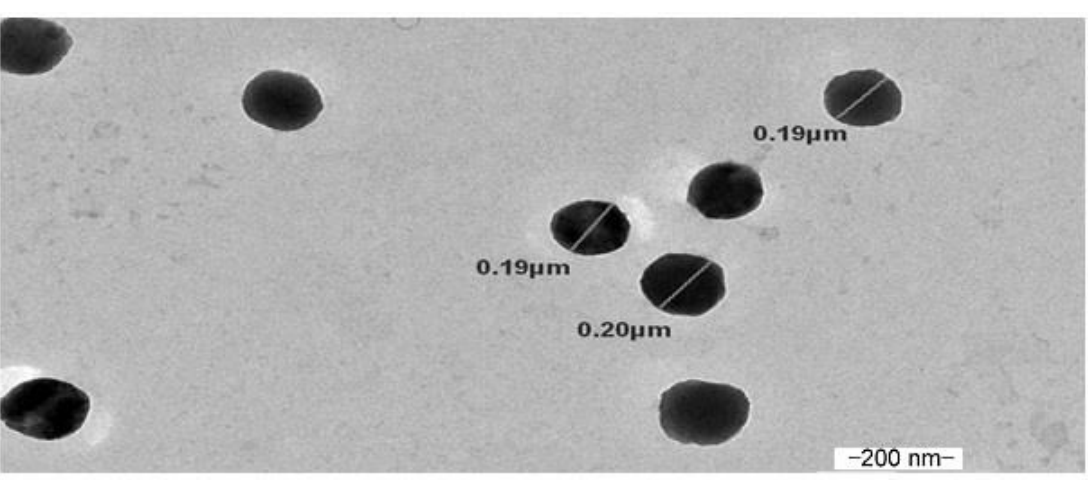
Figure 4. In vitro release profile of CS NPs loaded with MDZ (F32 D1). Due to the hydration and swelling of CS, the drug might be constantly released from the core of NPs through diffusion and erosion in later stages [39,40]. The data obtained from the in vitro release profile were fitted into standard release equations (zero, first, Higuchi, and Korsemeyer – Peppas model) to study the release kinetics. By analyzing the correlation coefficient value of the various models, the model that best fits the release data was selected. It was found that the release of the drug from NPs followed first-order release kinetics as indicated by a greater r 2 value of 0.967. As indicated from the release data fitted in the Korsemeyer – Peppas equation, it was found that the drug release from CS NPs was by a non-Fickian diffusion mechanism, since the value of release exponent ( n ) was 0.589.